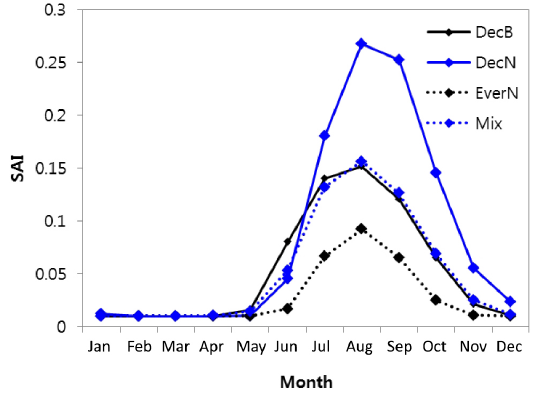
Figure 4. Monthly averaged SAI in the Noah-MP during the pe- riod of 2001–2010 for deciduous broadleaf forest (DecB), decidu- ous needleleaf forest (DecN), evergreen needleleaf forest (EverN), and mixed forest